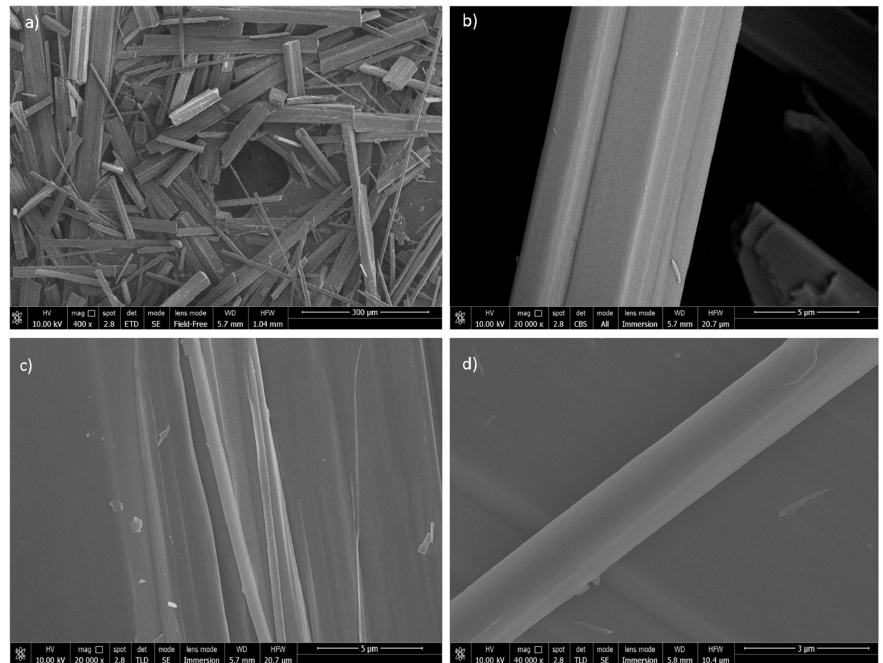
Figure 4. A gallery of FEG ‐ SEM pictures of the tremolite fibres after heating at 1000 °C. Very long fibre bundles are shown together with elongated particles and cleavage fragments ( a ); no sign of surface recrystallization are clearly observed for the longer and thicker fibres (e.g., a single 5 μ m thick fibre bundle shown on b ) while single thin fibrils show more irregular and granular surfaces, possibly indicating recrystallization ( c , d ).